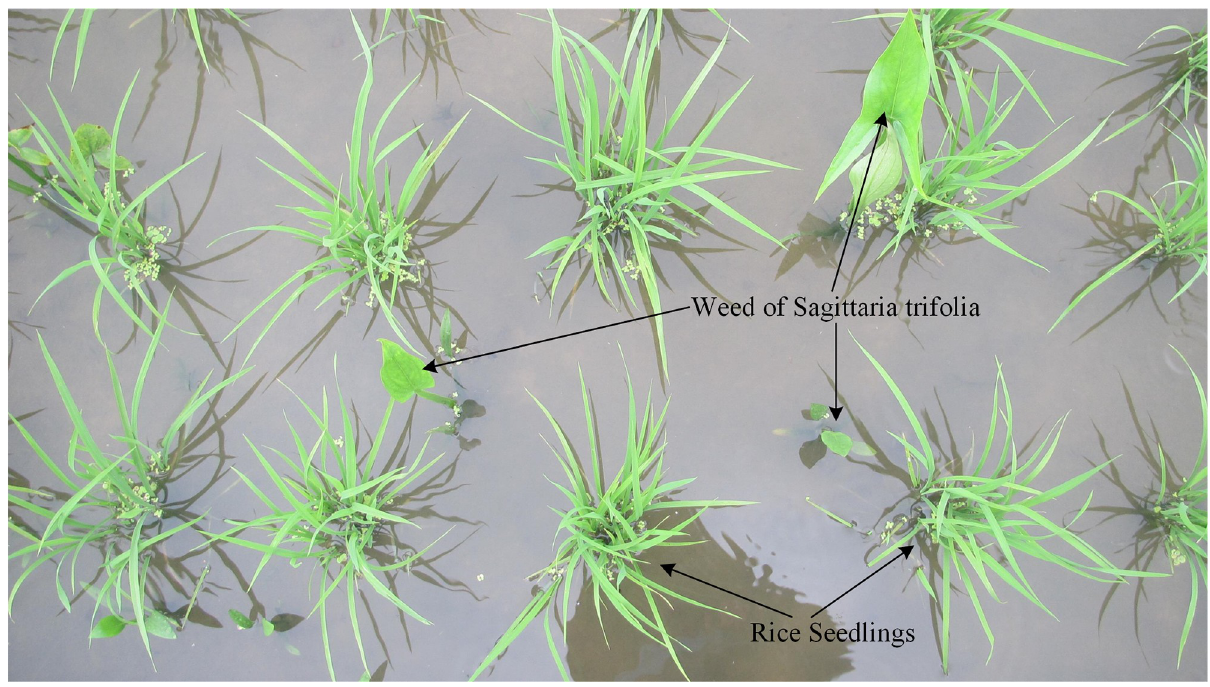
Fig 1. Rice seedlings and weeds images in the paddy field.